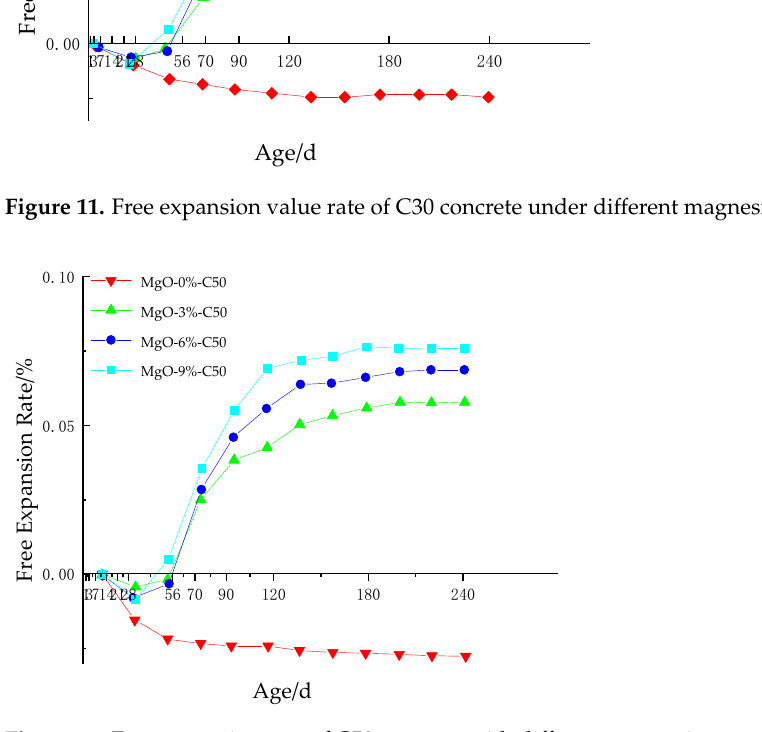
Figure 12. Free expansion rate of C50 concrete with different magnesia contents.